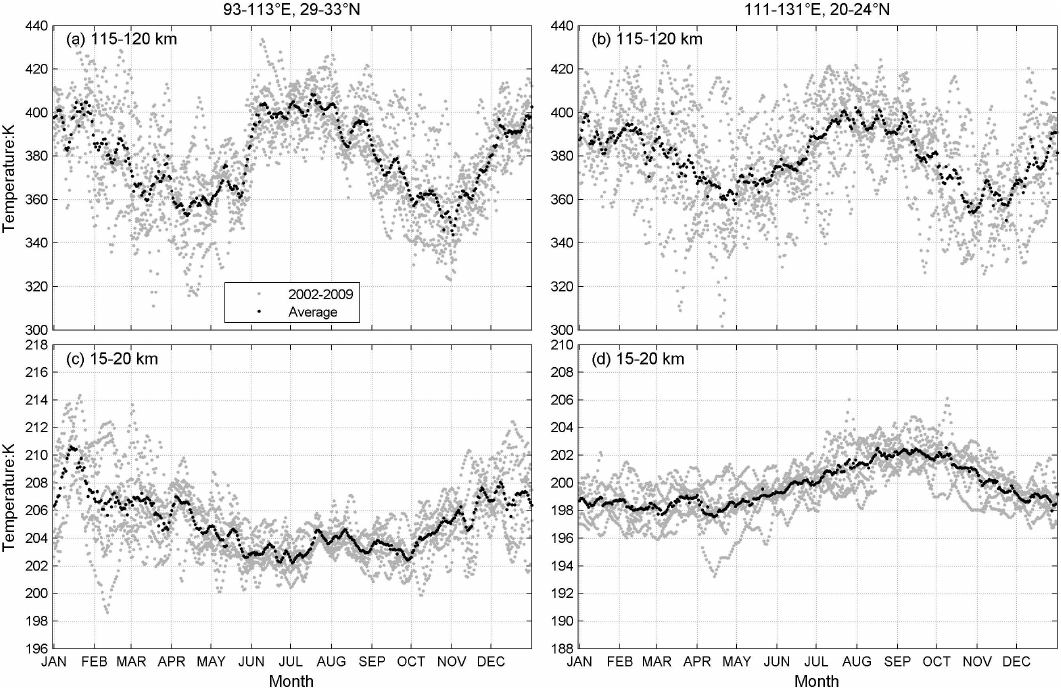
Fig. 2. The annual variation of Tn around the epicenters of the Wenchuan (left panels) and Pingtung (right panels) earthquakes during 2002– 2009. Gray points are the 5 day moving average of the individual Tn measurements at two height regions of 115–120km (upper panels) and 15–20km (lower panels). The dark points are the daily